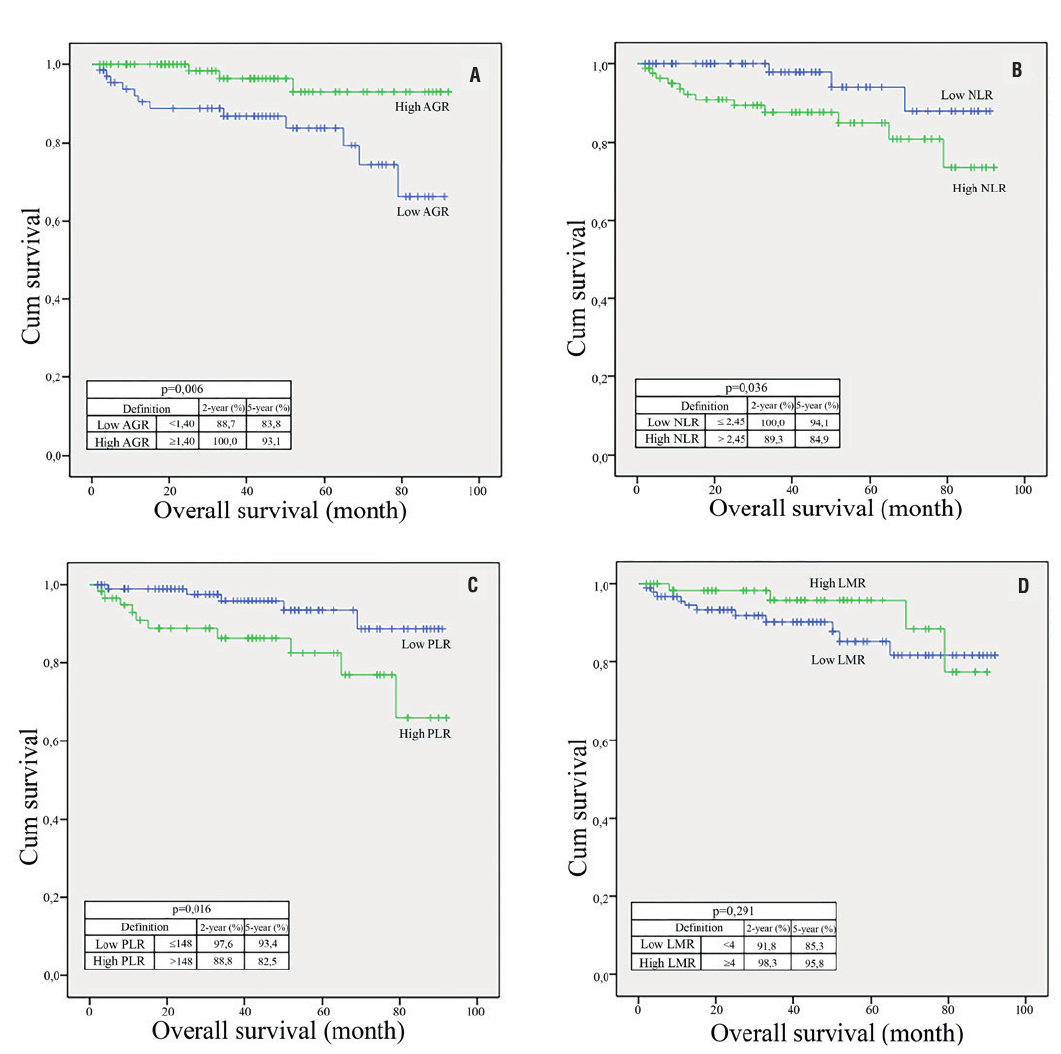
Figure 5 - Kaplan–Meier curves predicting overall survival, and 2 and 5-year overall survival probability, groups categorized by the pretreatment (A) albumin / globulin ratio (AGR), (B) neutrophil / lymphocyte ratio (NLR), (C) platelet / lymphocyte ratio (PLR), and (D) lymphocyte / monocyte ratio